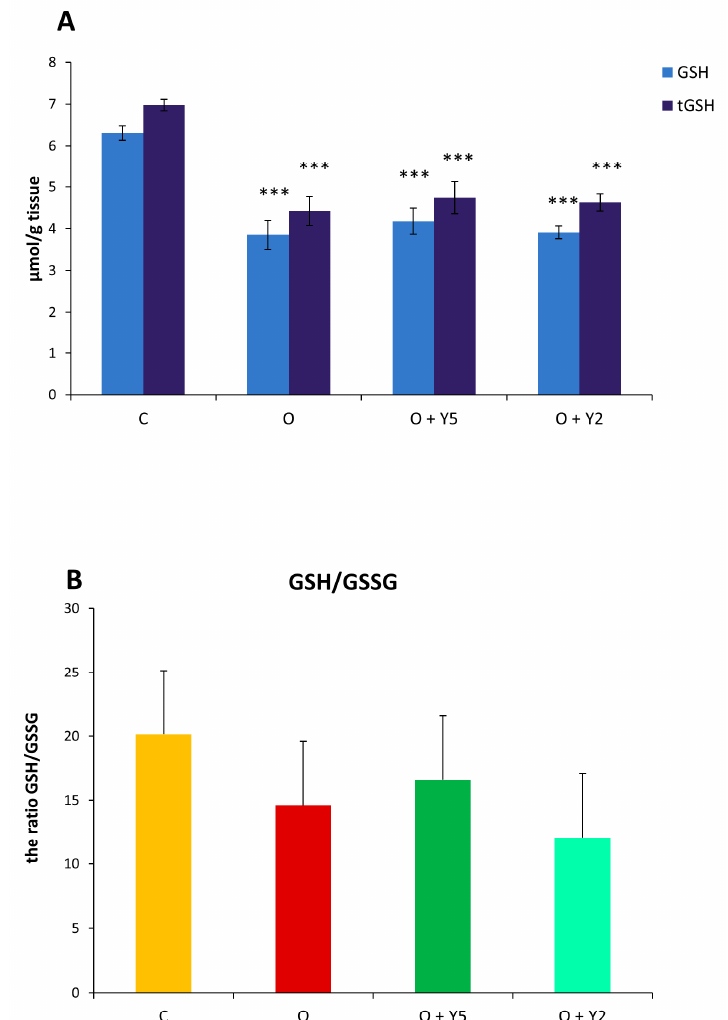
Figure 6. The level of reduced (GSH) and total (tGSH) glutathione ( A ) and the GSH/GSSG ratio ( B ) in the livers of rats. C—control rats fed a standard diet; O—rats fed with HFD; O + Y5—rats fed with HFD and treated intraperitoneally (i.p.) with yohimbine at a dose of 5 mg/kg/day for 30 days; O + Y2—rats fed with HFD and treated intraperitoneally (i.p.) with yohimbine at a dose of 2 mg/kg/day. Data are presented as the mean ± SEM, n = 6 per group. Statistical analysis was performed using a one-way ANOVA; symbols indicate significance of differences according to the Tukey post hoc test, *** p < 0.001 vs. group C.